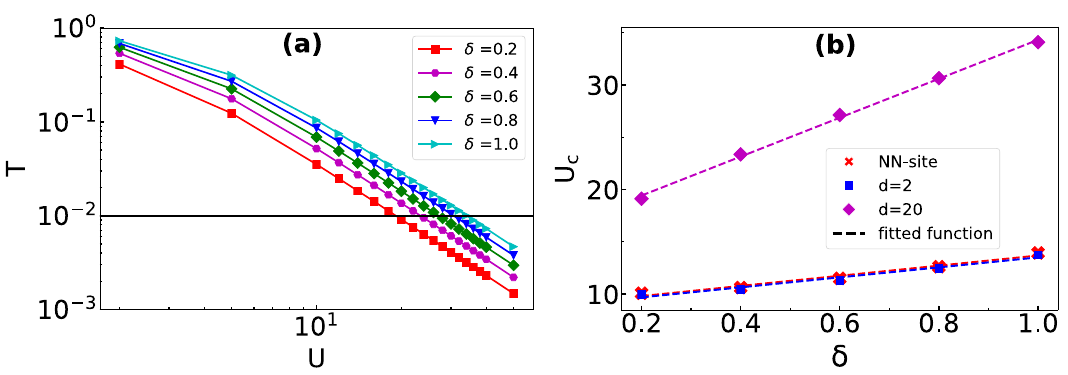
Figure 14. ( a ) The transmission coefficient T is plotted as a function of U for different values of δ in the log–log scale for the initial state given in Eq. (13) at t = 23 J − 1 . The dashed line marks T = 10 − 2 which is considered as the critical T for zero transmission and its point of intersection with different curves are the corresponding U c . ( b ) The plot between U c and δ is obtained by evolving the initial states given in Eq. (11) to t = 7 J − 1 (red stars), Eq. (12) to t = 7 J − 1 (blue squares) and Eq. (13) to t = 23 J − 1 (magenta